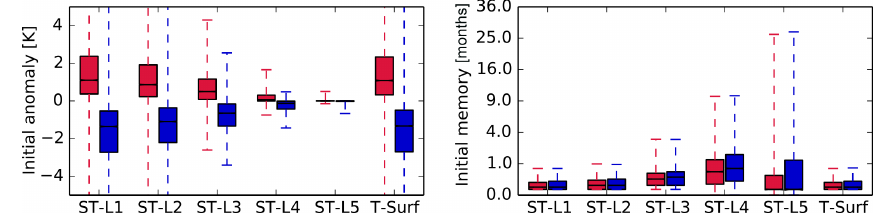
Figure 9. Global statistics for (cid:49)θ 0 (left) and τ 0 (right) in soil layer (ST-L1–5) and surface temperatures (T-Surf) in the wet (blue) and dry (red) initialized ensemble simulations for all land surface grid cells. The whiskers indicate the 1st and 99th percentiles, the box indicates the interquartile range, and the notch indicates the median. Note the quadratic axis for the memory statistics.